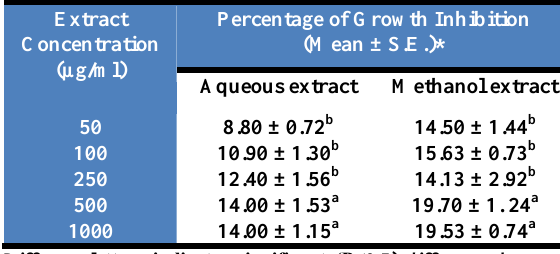
Table, 3: Growth inhibition effects of green tea extracts (aqueous and methanolic) on MEF cell